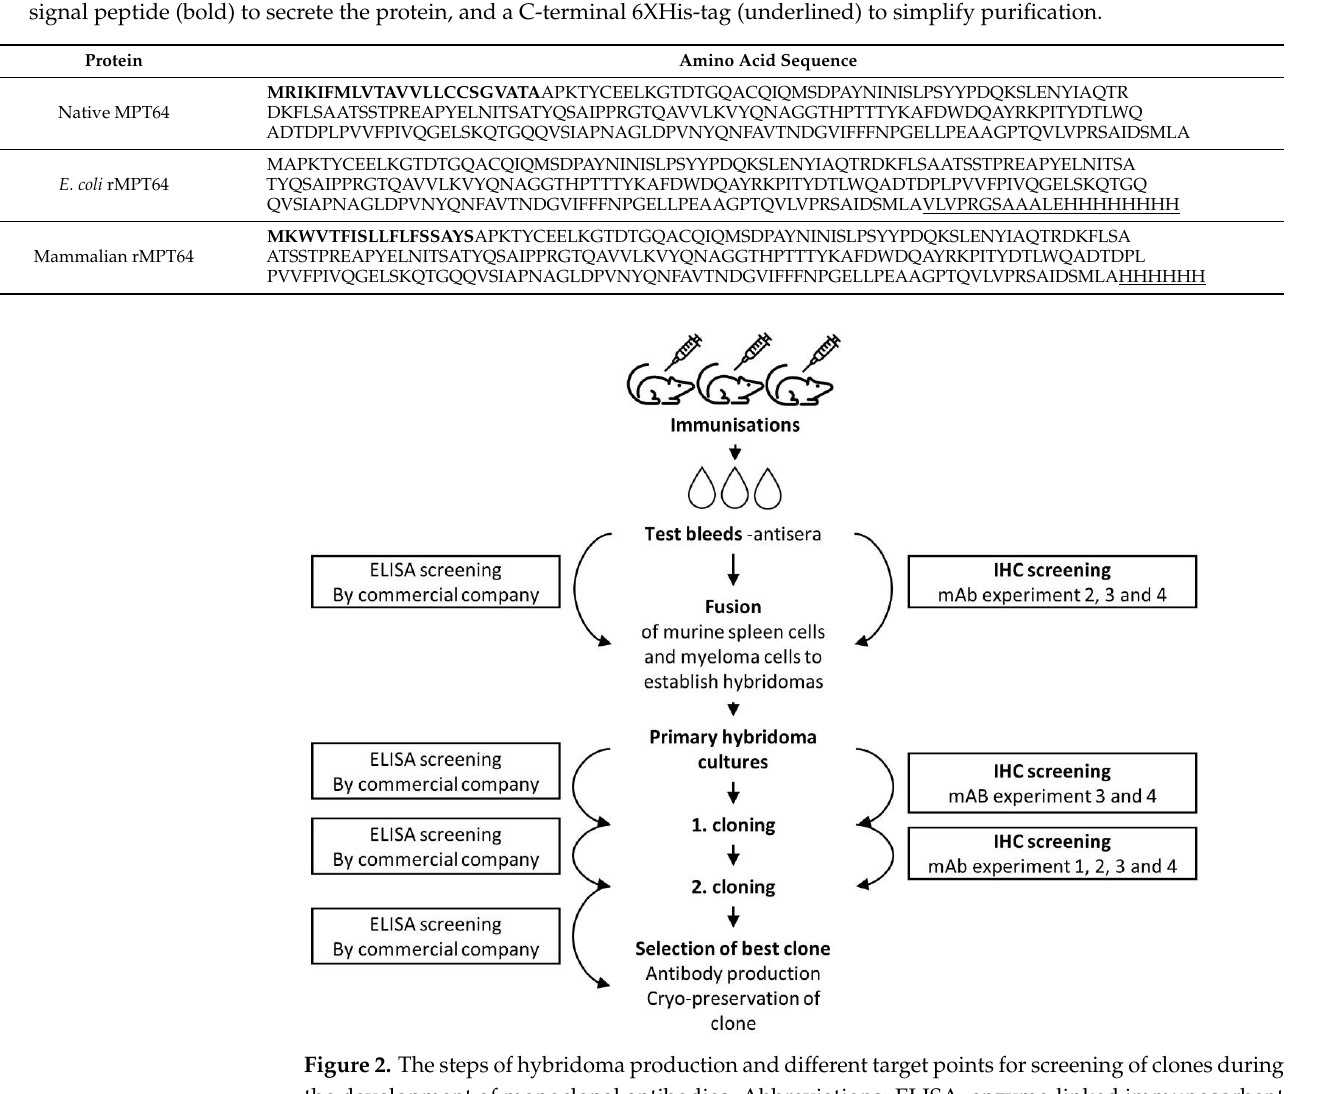
Figure 2. The steps of hybridoma production and different target points for screening of clones during the development of monoclonal antibodies. Abbreviations: ELISA, enzyme-linked immunosorbent assay, IHC, immunohistochemistry; mAb, monoclonal